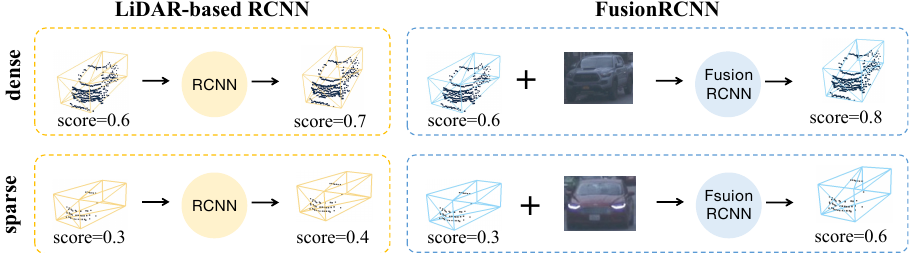
Figure 1. Comparison of our method with previous LiDAR-based two-stage methods. LiDAR-based methods often struggle to determine object categories and produce less confident scores correctly. The confidence score indicates the likelihood of an object (e.g., vehicle) being present in the box and the accuracy of the bounding box. Our approach, on the other hand, effectively integrates point cloud structure with dense image information, allowing us to overcome these